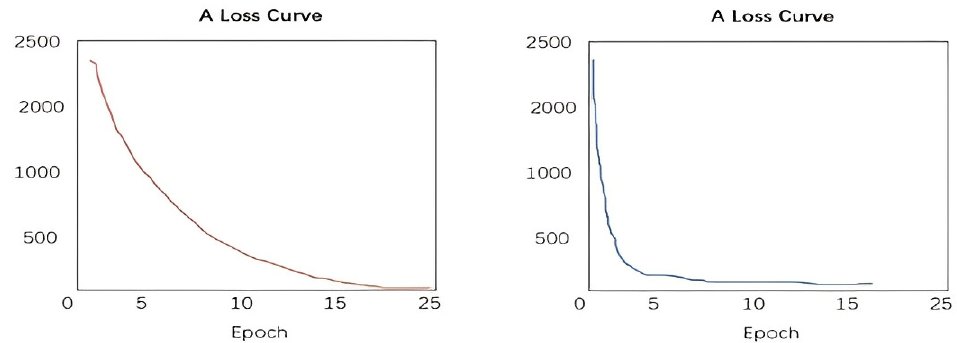
Figure 9. The loss curves of the SSD model ( left ) and the transfer learning model ( right ).